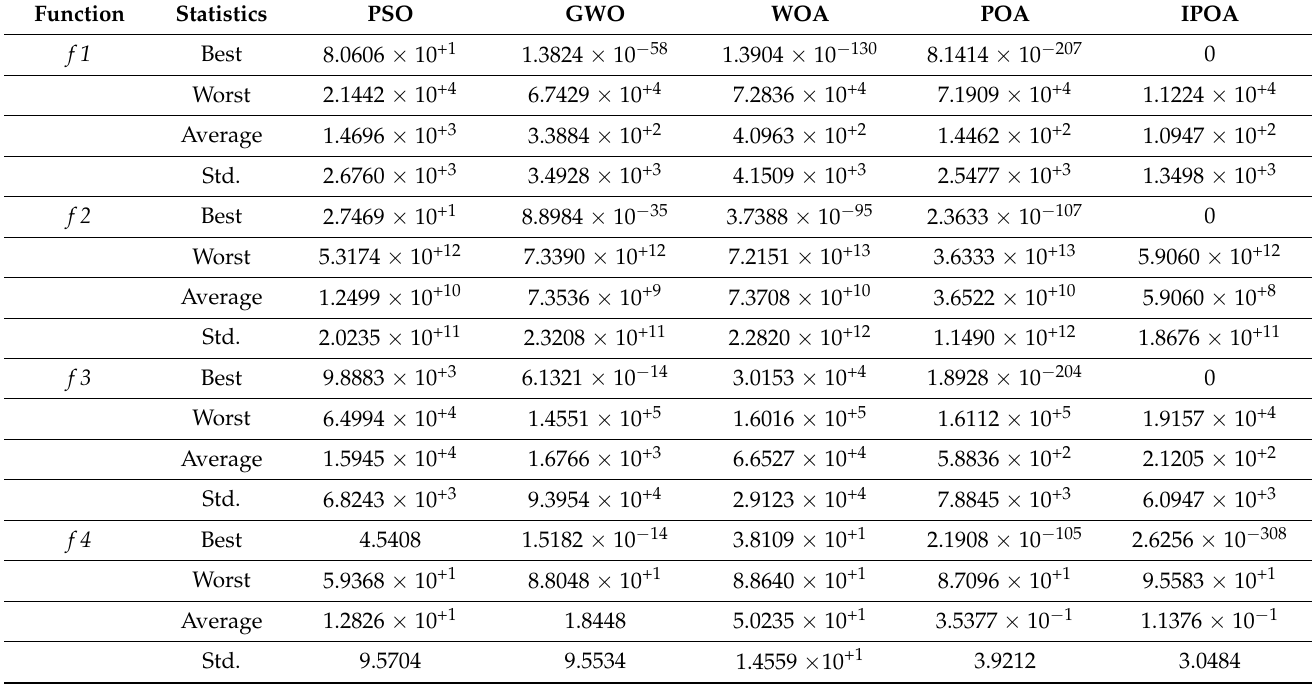
Table 3. Statistical results for unimodal benchmark